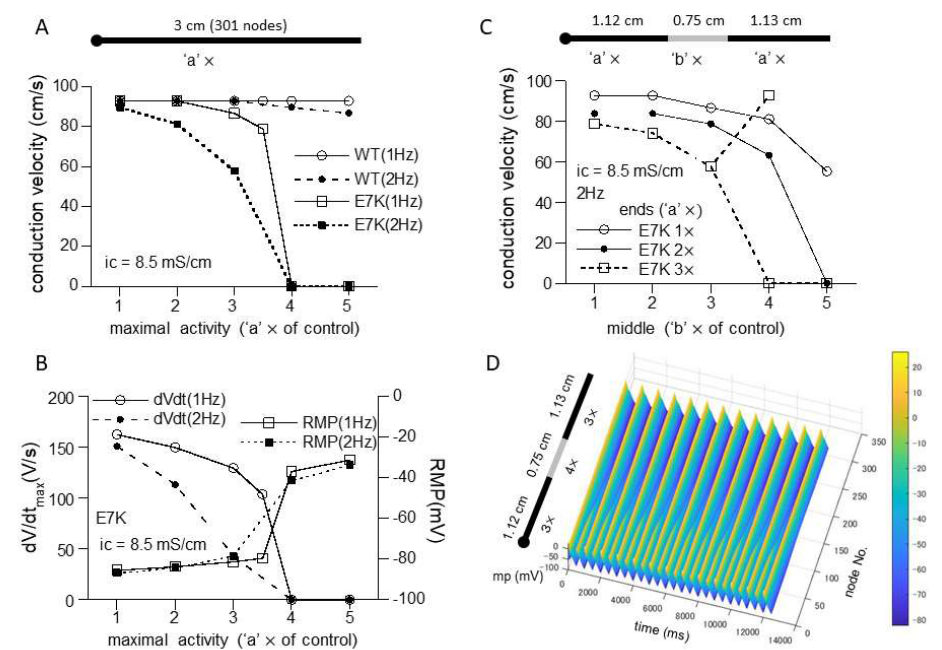
Figure 7. Heterogeneous expression of E7K causes partial conduction block. ( A , B ) relationships of CV (A), dV/dt max (B) or RMP (B) against the density of wild-type or E7K mutant TRPM4 channels with the intracellular conductivity of 8.5 mS/cm. Definitions of the ordinate and abscissa are the same as in Figure 6C,D. ( C ) CV-channel density relationship for E7K-mutant TRPM4 channel under spatial heterogenous conditions consisting of two different densities at the middle (‘b’ ×) and both ends (‘a’ ×). For better visualization, only the cases for 1× to 3× with intracellular conductivity of 8.5 mS/cm and 2 Hz-pacing are shown. ( D ) spatiotemporal profile (surface plot) of partial conduction block (2:1) observed for the case of open squares in C in which the densities in the middle and ends are set to 4× and 3×, respectively. The last 25 out of 50 stimulations are shown.